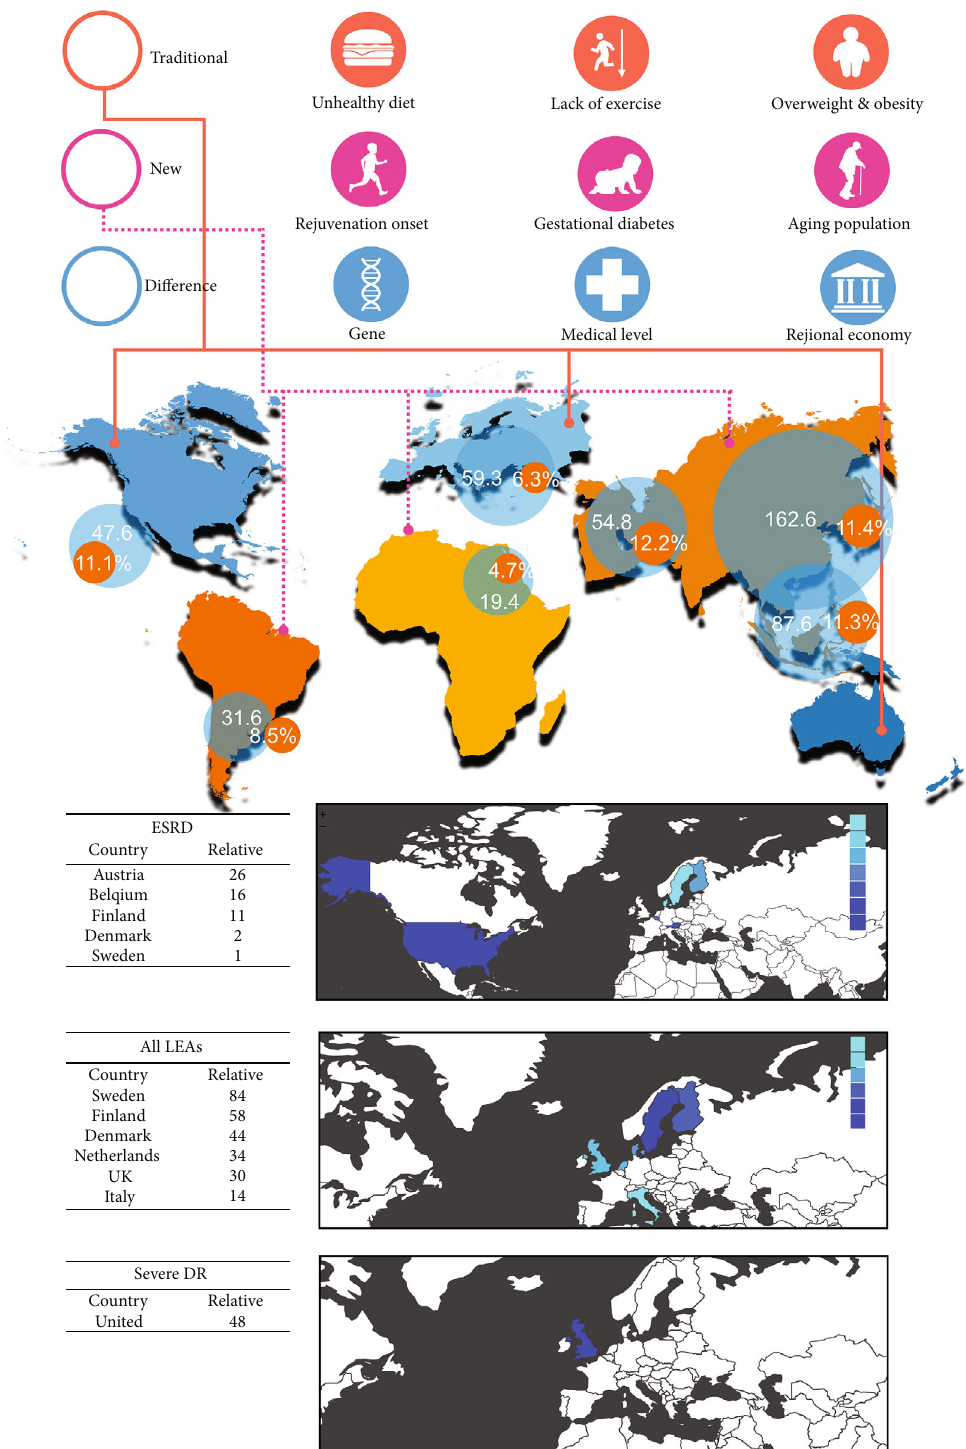
Figure 1: The risk factors for diabetic vascular complications and the decrease in morbidity caused by treatment. Worldwide, the incidence of diabetes has shown an overall upward trend. It is worth noting that there are obvious di ff erences in the incidence of diabetes between di ff erent regions, which are presumably caused by di ff erences in economic development, medical care levels, and genetics between regions. Due to an unhealthy diet and lack of exercise, which leads to obesity, current diabetes prevention also needs to pay attention to the e ff ects of dietary changes in some areas, childhood obesity, gestational diabetes, and population aging. Fortunately, better medical treatment can bring about improvements in the incidence of diabetic vascular complications. (For the convenience of observation, the connection between Europe and Asia is split. The data in the picture come from an article that analyzes the changes in IDF and vascular complications [1,